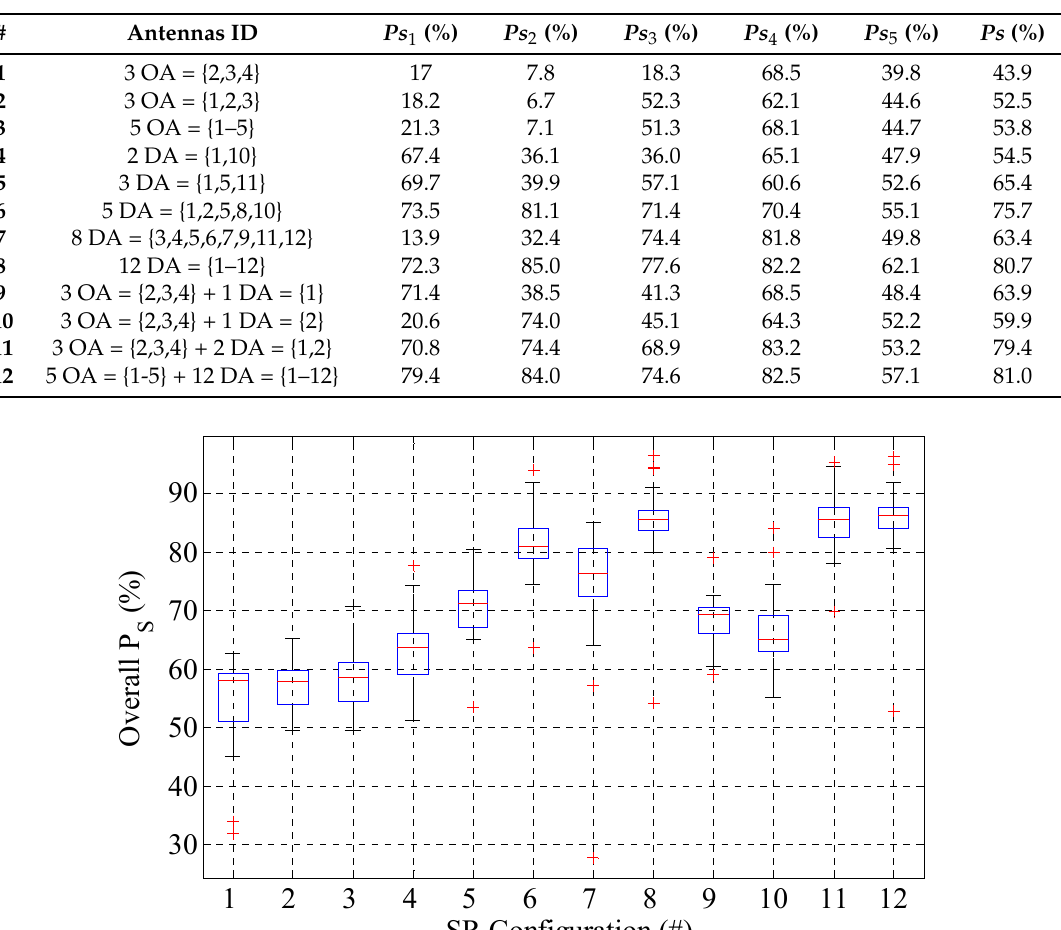
Table 2. Success probability per room P Sr ( r -th room) and overall P S .